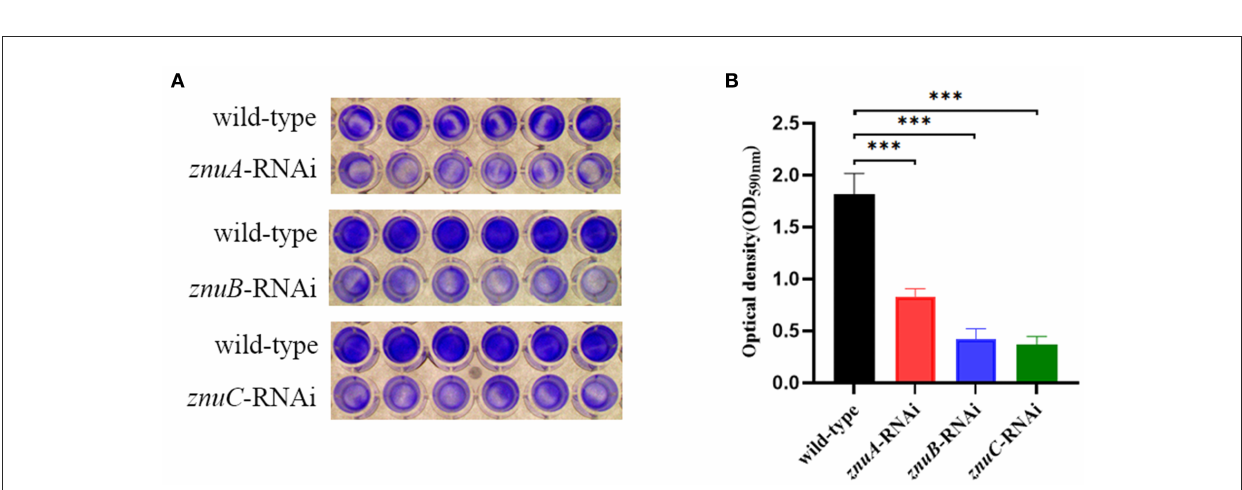
FIGURE4 Biofilm forming ability assay of wild-type, znuA , znuB, and znuC -RNAi strains of A. salmonicida SRW-OG1. (A) was the typical figure of the biofilm formation of wild-type, znuA , znuB and znuC -RNAi strains of A. salmonicida SRW-OG1; (B) was the biofilm formation histogram of wild-type, znuA , znuB, and znuC -RNAi strains of A. salmonicida SRW-OG1. Data were presented as mean ± standard deviation (SD) ( n = 3). *** P < 0.001.